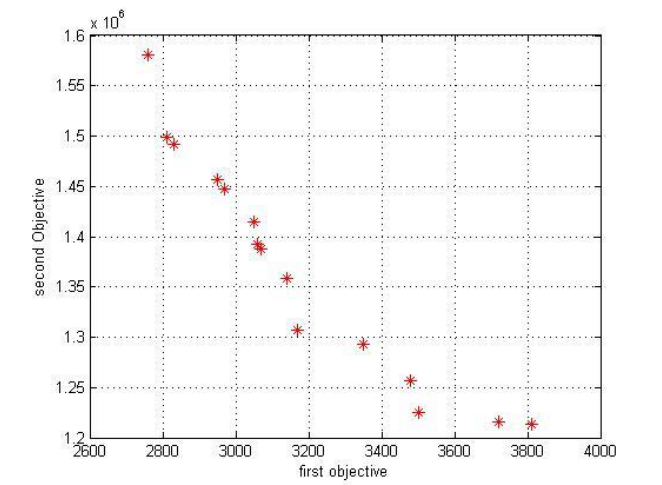
Fig 8 . Pareto solutions obtained for problem 10